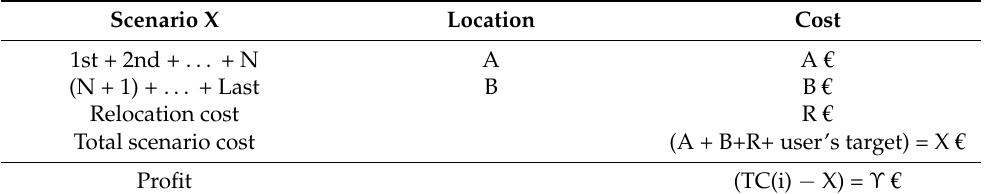
Table 4. Optimization process for dynamic planning of construction site.